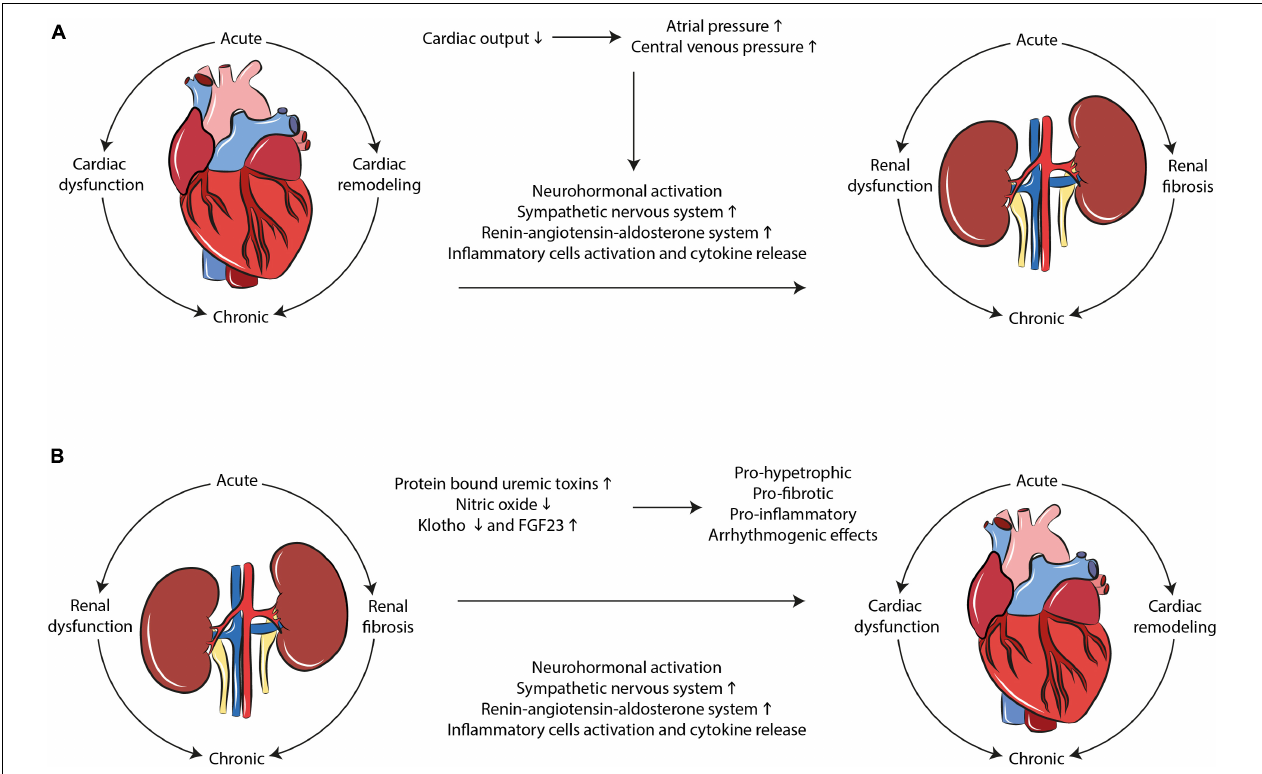
FIGURE 1 | Mechanisms interplaying in CRS development. Multiple complex and dynamic mechanisms play a role in the occurrence of CRS. SNS/RAAS system activation, oxidative stress, and inflammation as well as tissue remodeling and fibrosis are the main hallmarks of the disease in both (A) cardio-renal and (B) reno-cardiac types of